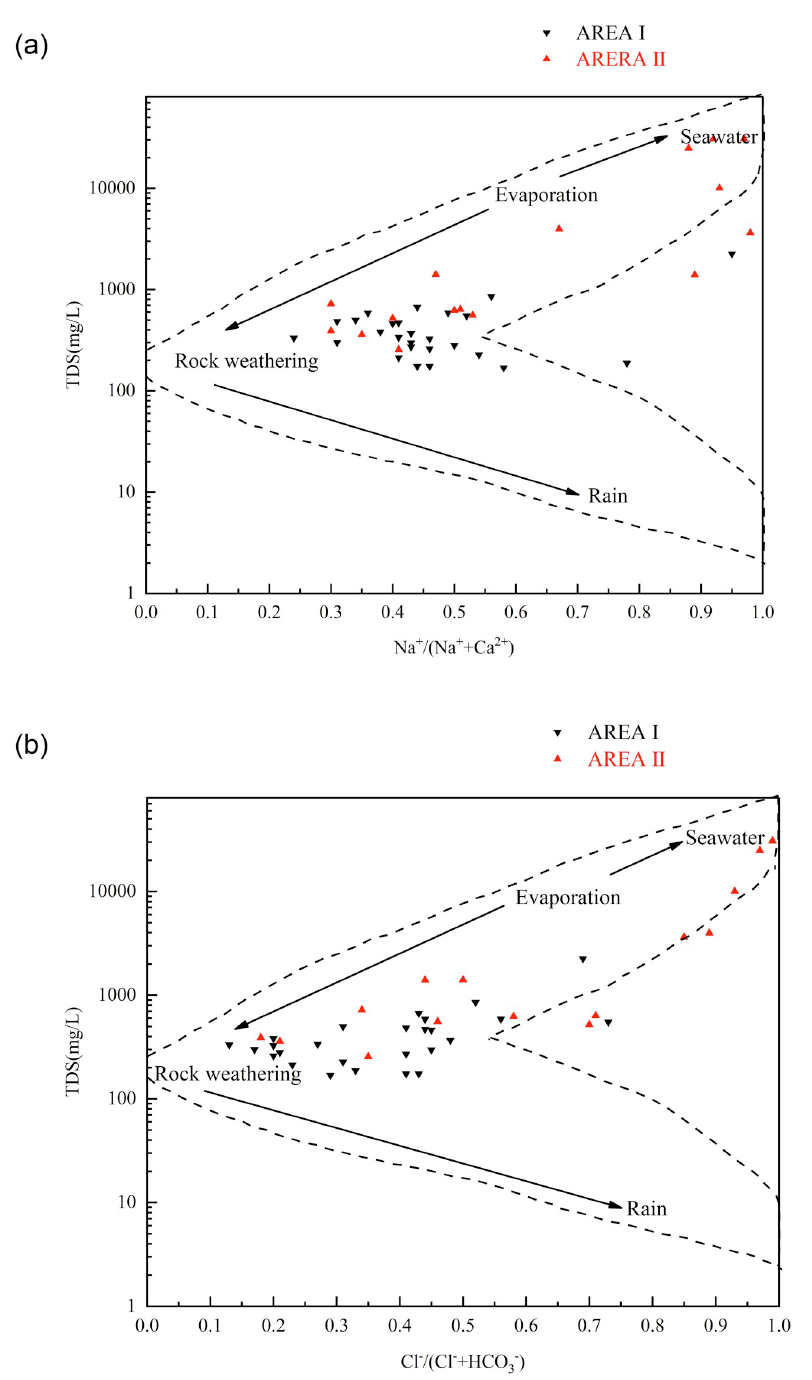
Fig 4. Gibbs plots of the study